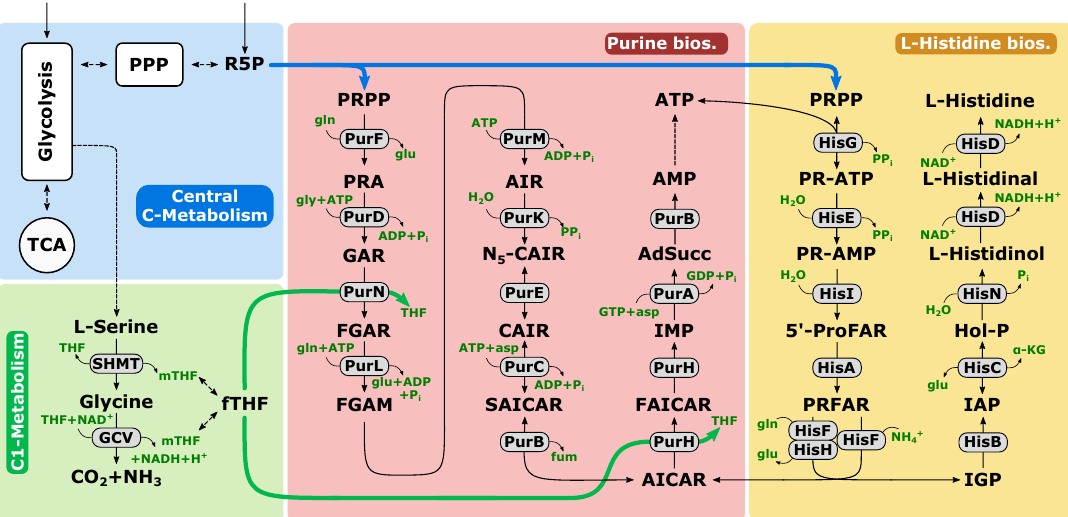
Figure 1. High-level overview of relevant metabolic pathways of C. glutamicum for the production of l -histidine. The central carbon metabolism (blue), one carbon metabolism (green), purine biosynthesis (red), and l -histidine biosynthesis (yellow) are shown.